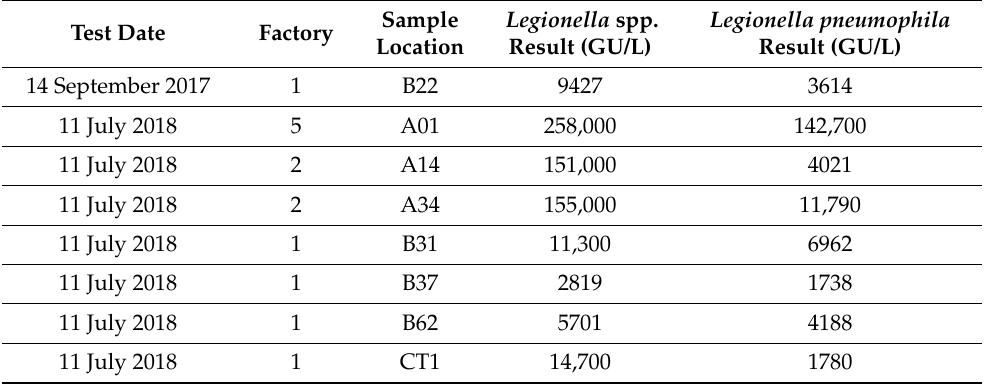
Table 4. Areas with Legionella pneumophila qPCR readings >LOQ (and comparison to Legionella spp. qPCR